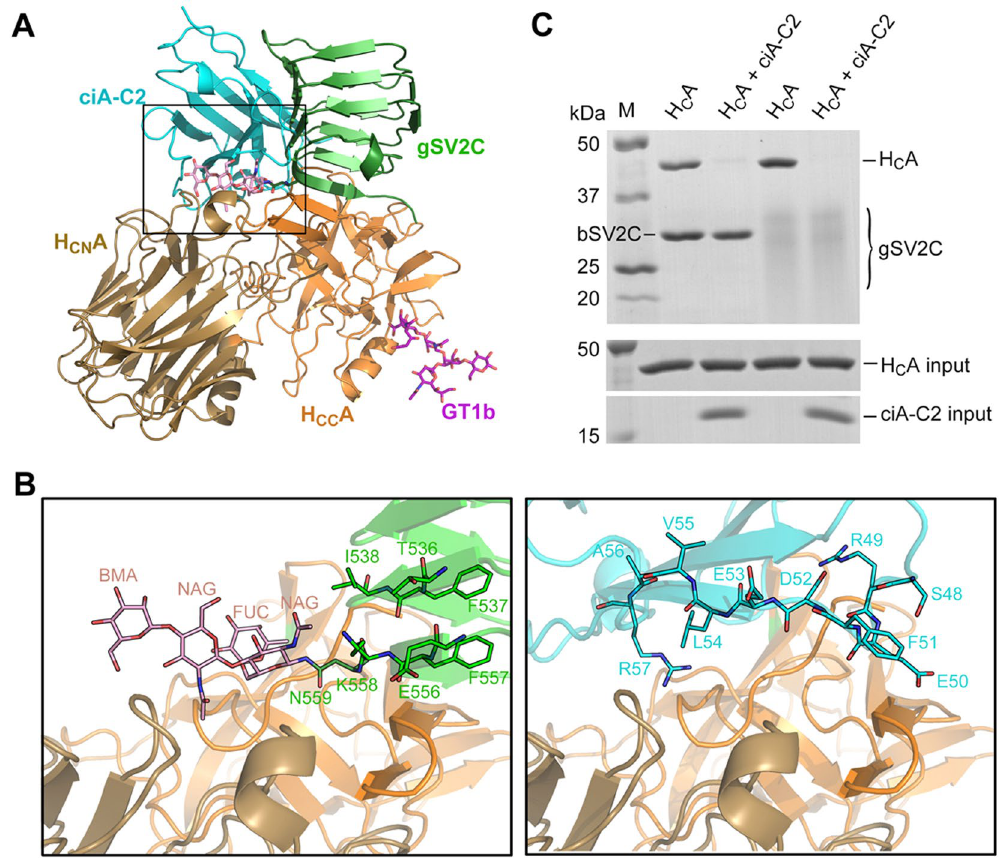
Figure 4. ciA-C2 blocks BoNT/A1 binding to SV2. ( A ) Superposition of the structures of H C A1-ciA-C2, H C A1-gSV2C (PDB: 5JLV), and H C A1-GT1b (PDB: 2VU9) complexes. H C A1 and ciA-C2 are colored as in Fig. 3. gSV2C is colored in green while its N559 glycan is shown as pink sticks. GT1b is shown as purple sticks. Close-up views of the interface highlighted in the box is shown in ( B ), where the structures of H C A1-gSV2C and H C A1-ciA-C2 are shown in the left and the right panel, respectively. T536-T538, E556-N559 and the N559 glycan of gSV2C and the ciA-C2 residues S48-R57 that occupy the same space on H C A1 surface are shown as sticks. ( C ) ciA-C2 prevents H C A1 from binding to SV2C independent of its glycosylation state. Pull-down assay was performed using H C A1 as prey and the His-tagged bSV2C or gSV2C as baits. After binding, the Ni-NTA resins were washed twice, and the bound proteins were released from the resins and subjected to SDS-PAGE for